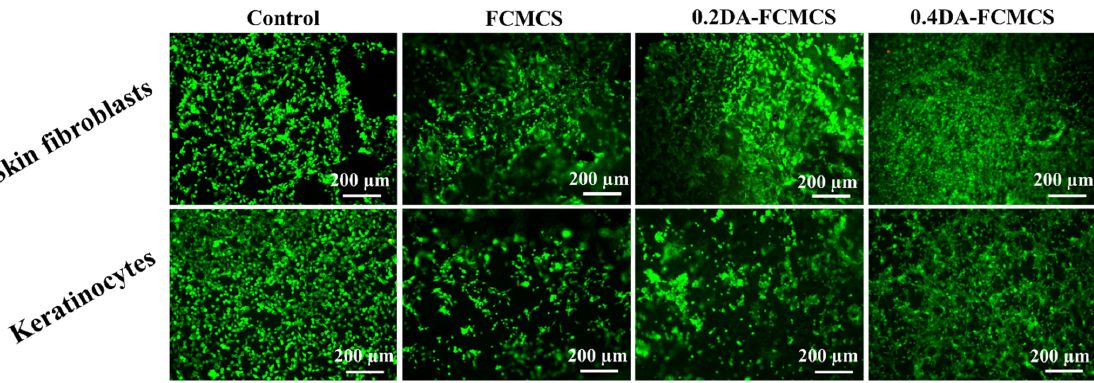
Figure 9. Biocompatibility of L/D fluorescence images of skin fibroblasts and keratinocytes cells treated with FCMCS, 0.2DA-FMCS, and 0.4DA-FCMCS hydrogels.